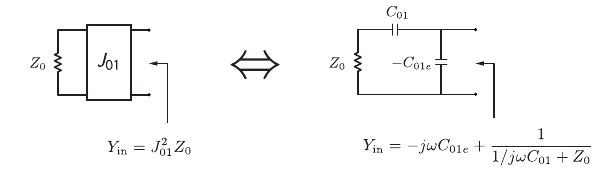
FIG. 26. Left: inverter at termination. Right: capacitive inverter